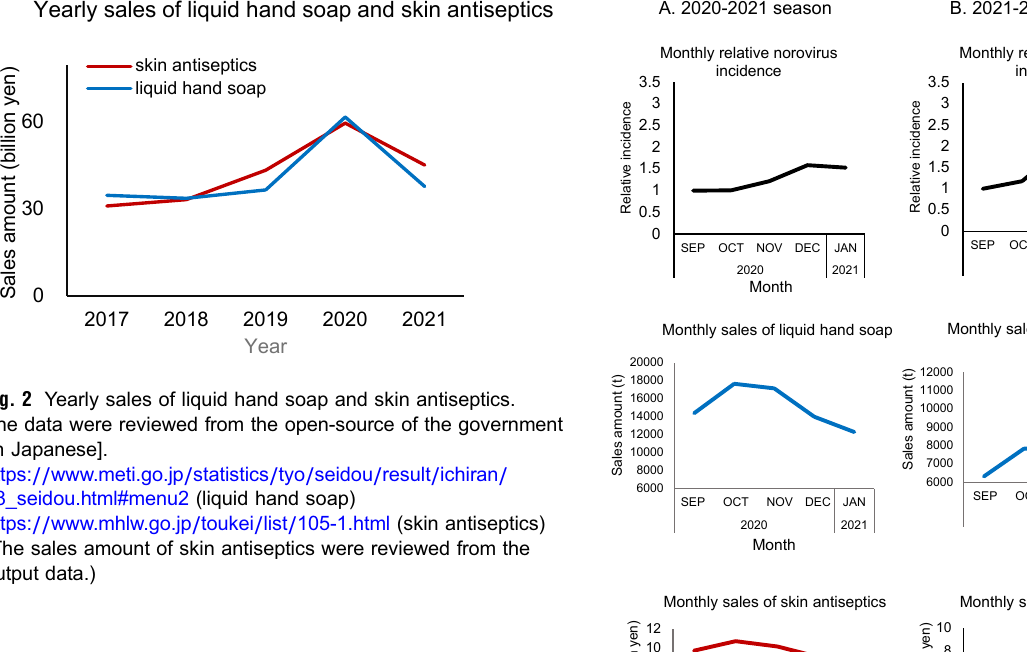
hygiene products (Spearman ’ s Rho = ¹ 0.88 and p = 0.002 for liquid hand soap; Spearman ’ s Rho = ¹ 0.81